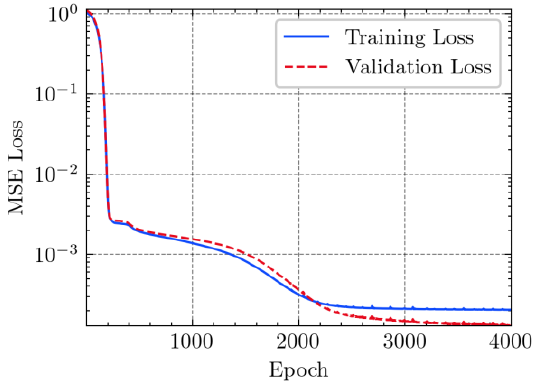
Figure 4. Loss function,